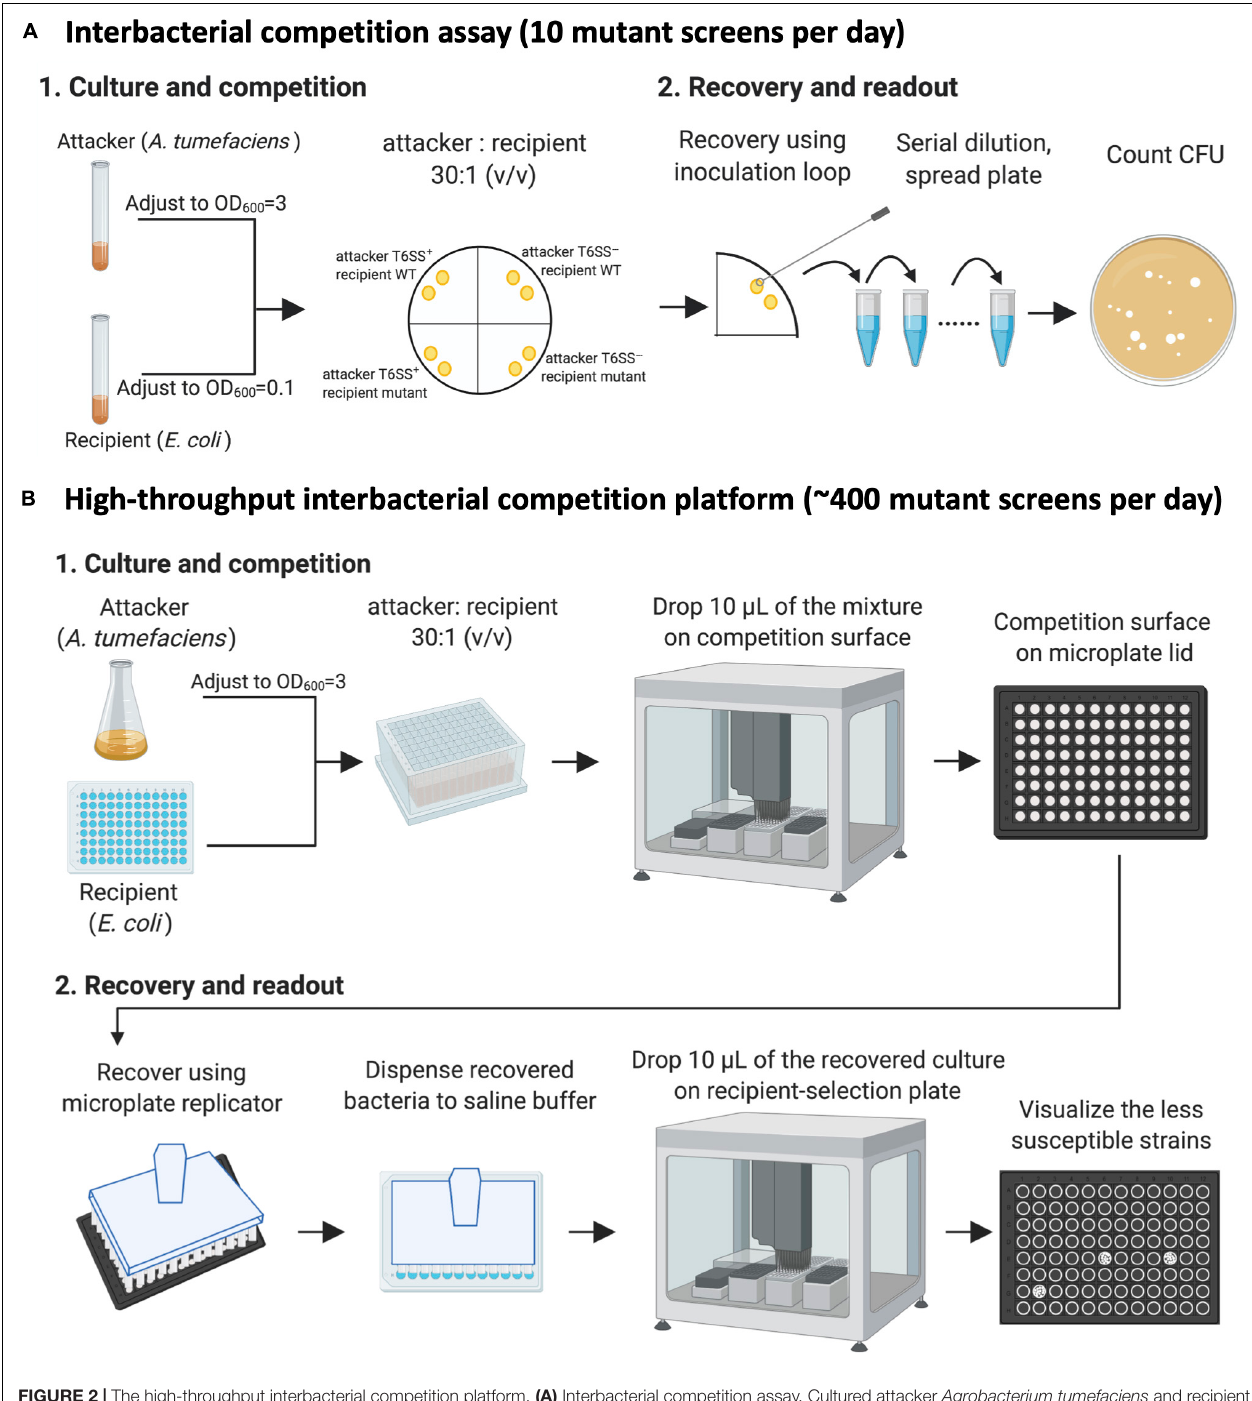
Frontiers in Microbiology |